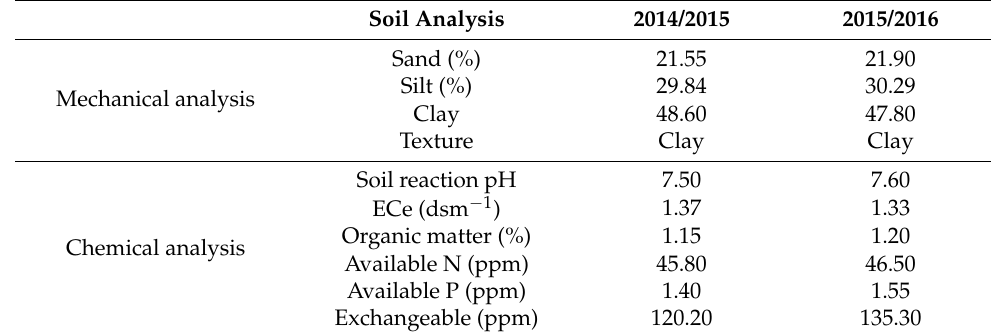
Table 1. Soil properties (mechanical and chemical) of the experimental sites (0–30 cm) during the 2014/2015 and 2015/2016